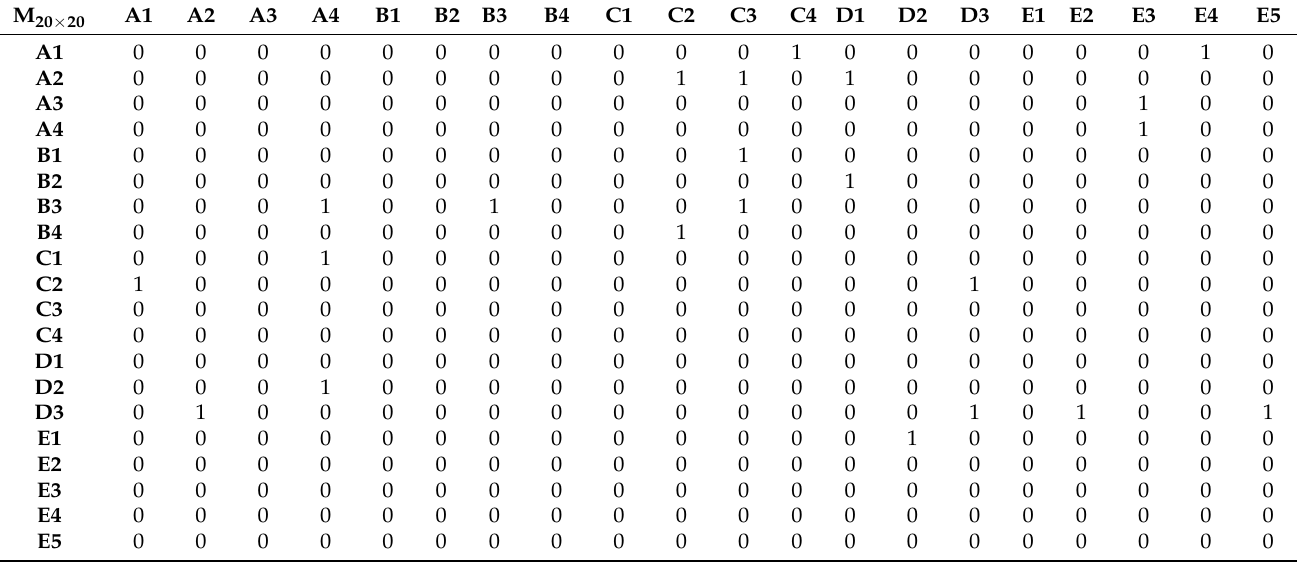
Table A3. General skeleton matrix S